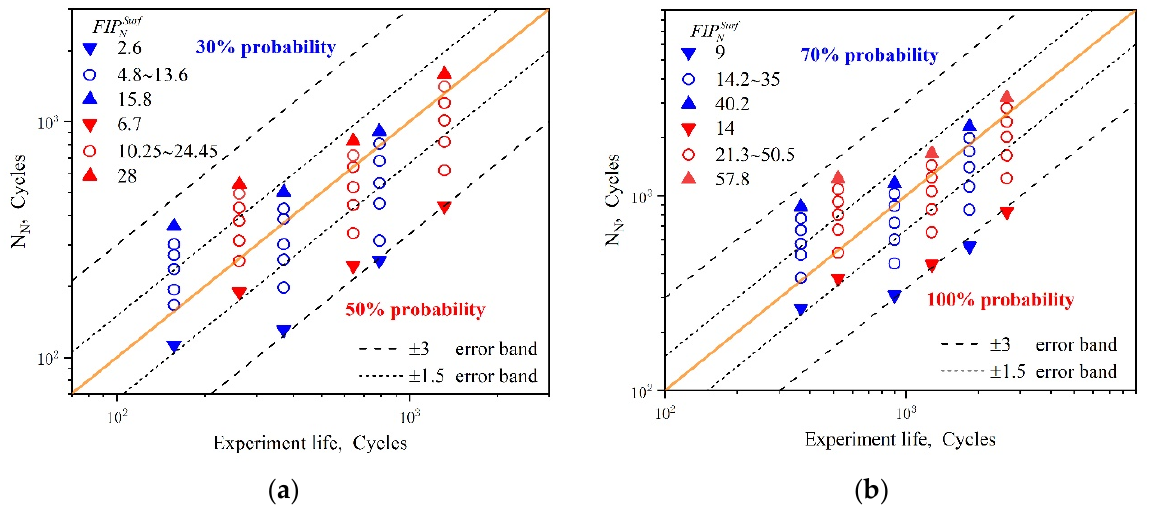
Figure 14. Comparisons between the experimental and predicted loading cycles for nucleation by using FIP Surf on the free surface: ( a ) 30% probability and 50% probability; ( b ) 70% probability and 100% probability.